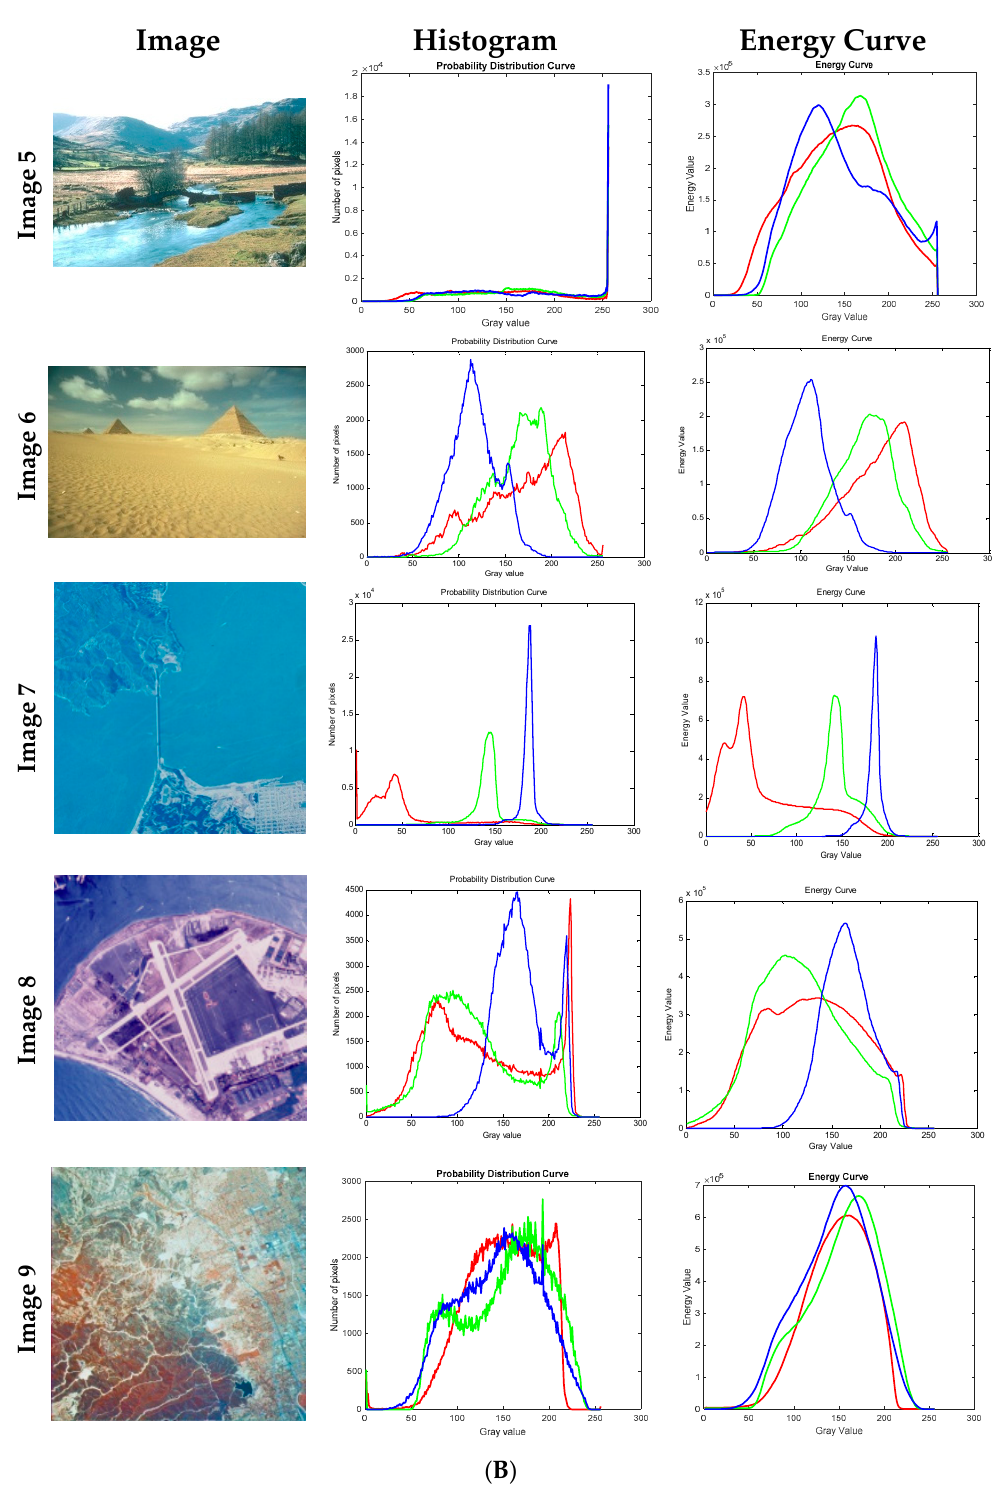
Figure 1. ( A ) Images considered for experimentation along with histogram and energy curves of images. Red, green, and blue color plots indicate histograms and energy curves of red, green, and blue components of input images. ( B ) Images considered for experimentation along with histogram and energy curves of images. Red, green, and blue color plots indicate the histograms and energy curves of red, green, and blue components of input images.